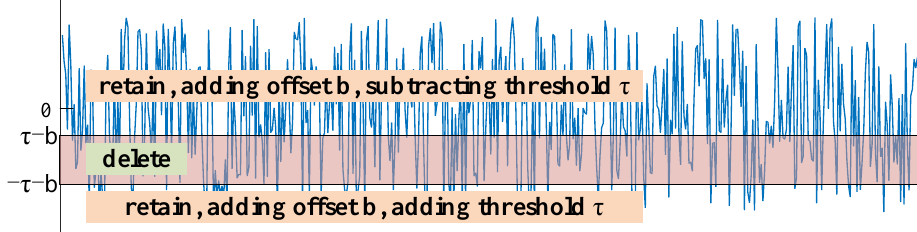
Figure 13. The soft thresholding function when b > 0.